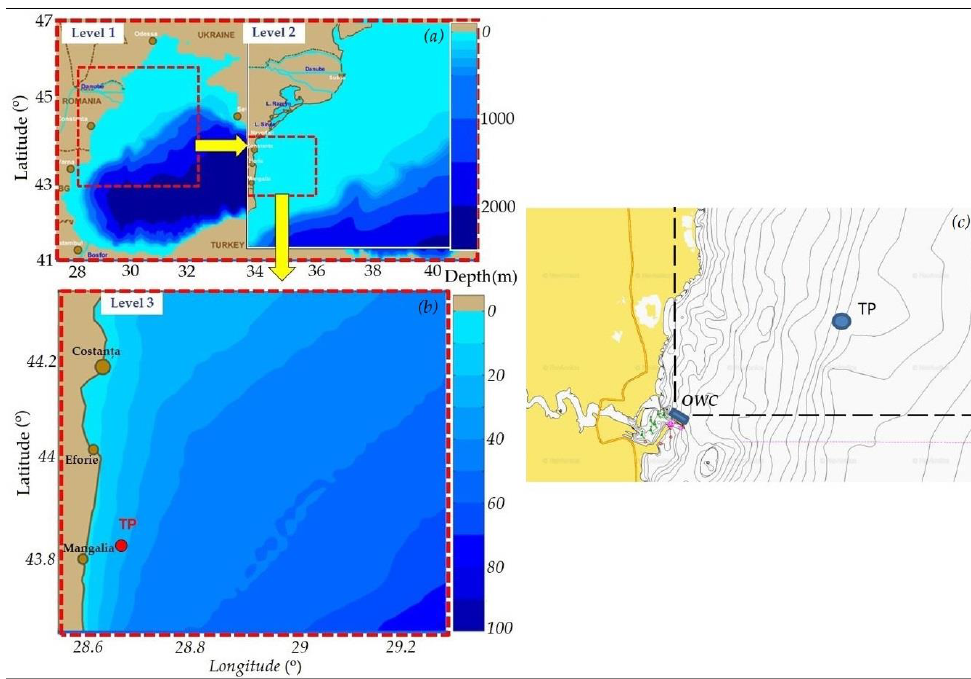
◦ < θ < ◦ 90 that influence the o o 0 90   that influence the considered